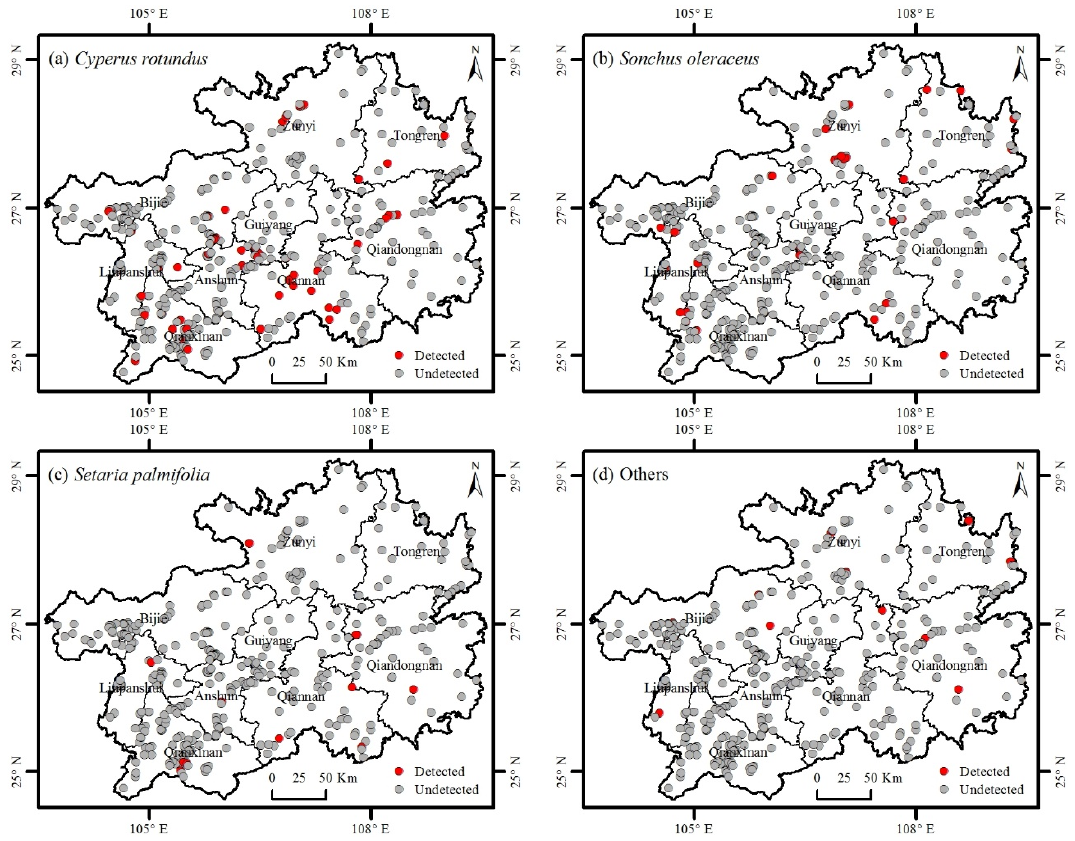
Figure 5. Distribution of generally invasive plants (Level 4). Red and grey dots indicate detected and undetected invasive species,